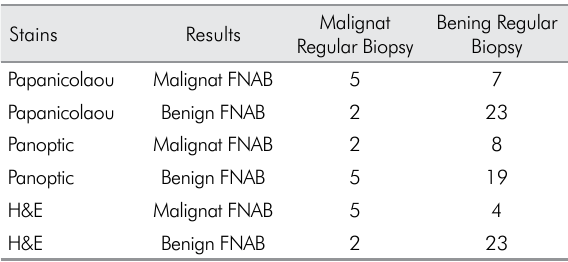
Table 1. Sensitivity and specificity for Papanicolaou, Panoptic and H&E stains.